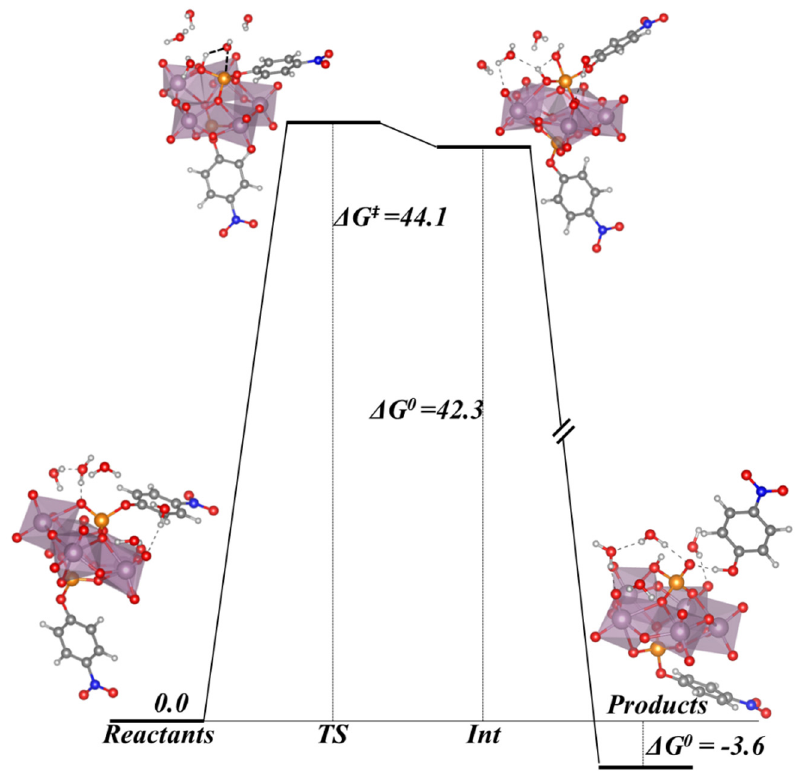
Figure 36. Mechanism of reaction for the pNPP hydrolysis with [Mo 5 O 15 (pNPP) 2 (H 2 O) 6 ] 6– . Gibbs free energies in kcal mol − 1 .